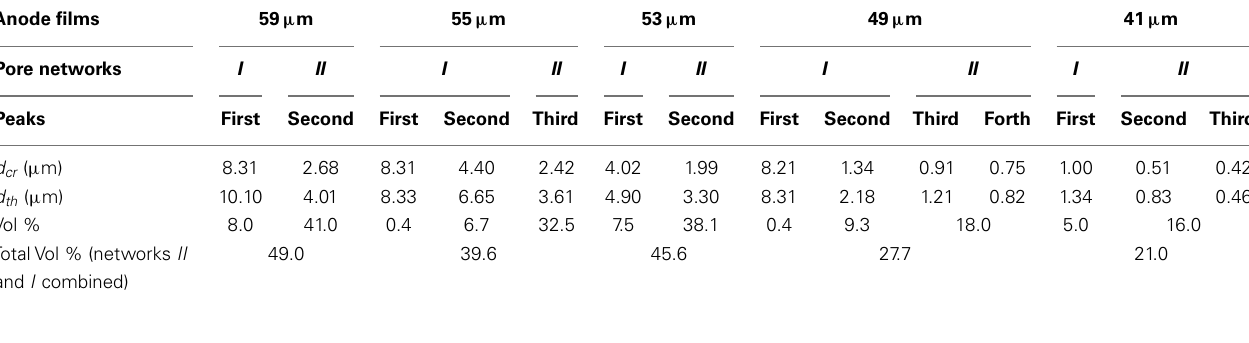
Table 3 | Data summary of results from wetting balance test for all the electrode films